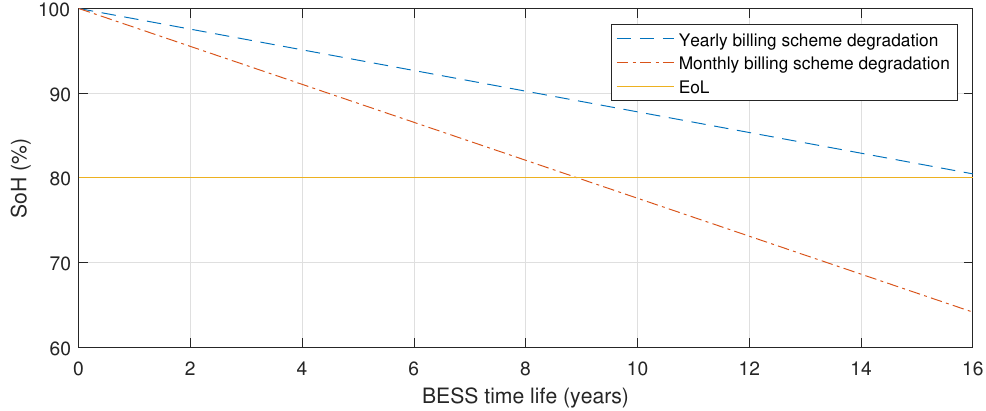
Figure 8. Extrapolation of the one-year results to represent the degradation after 10 years of usage for Profile A.